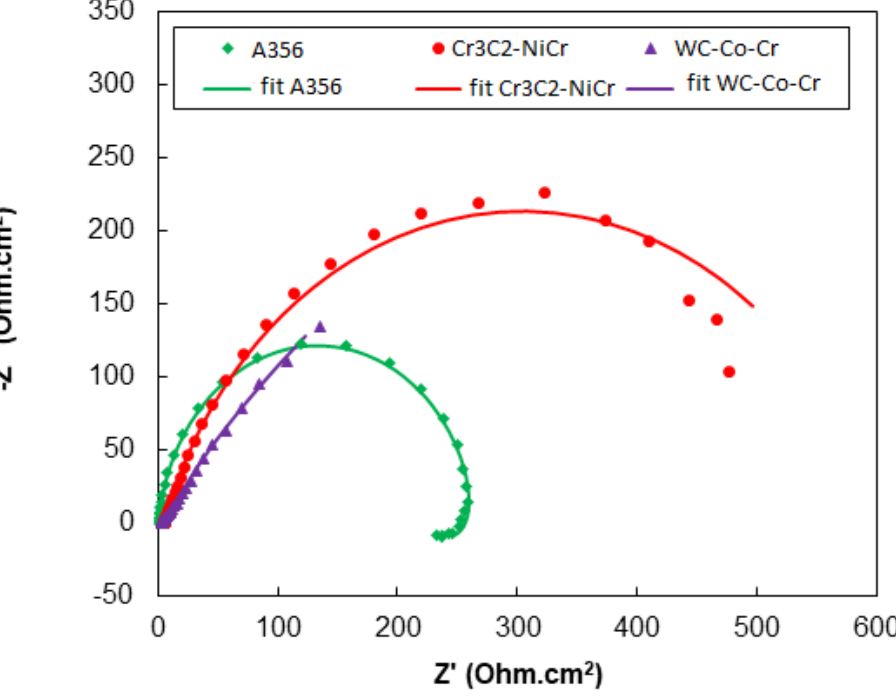
Figure 18. Nyquist curves of the samples plus the fitted results of the obtained data from the EIS tests based on the equivalents suitable circuit of the electrochemical system.